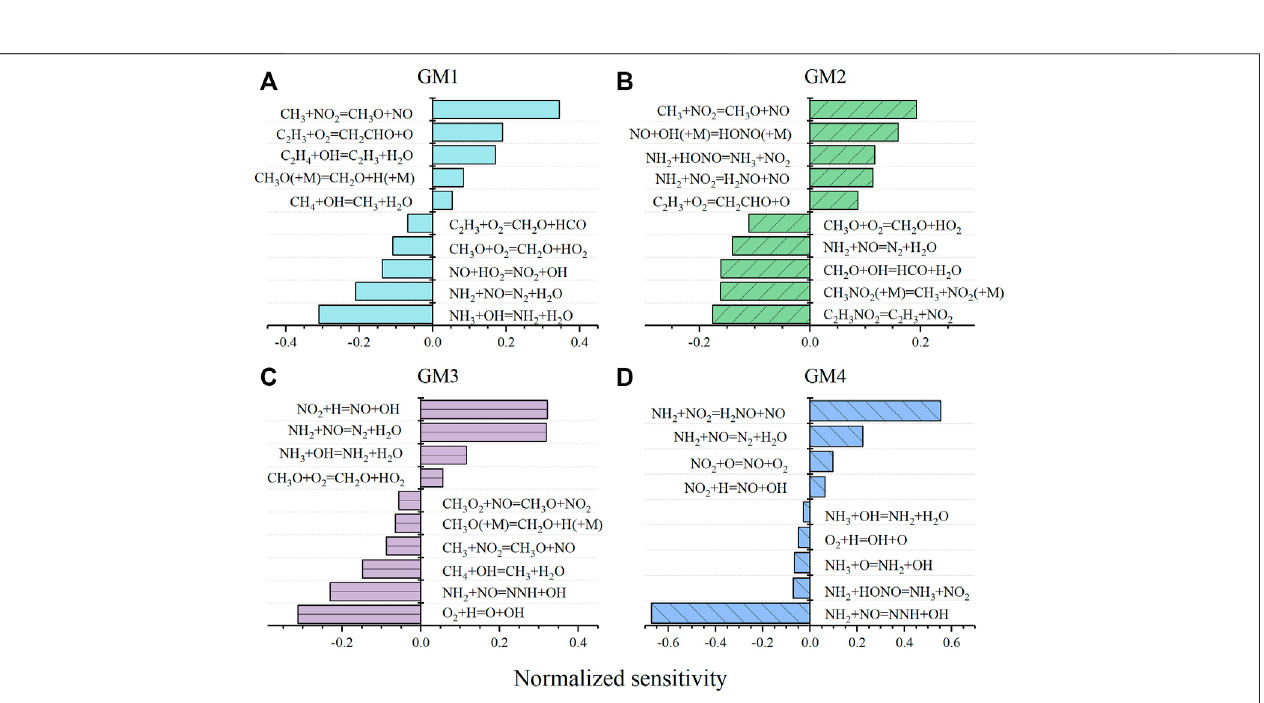
FIGURE 5 | Sensitivity analysis of NO during the fl ow reactor oxidation of GM1, GM2, GM3 and GM4 at 1213, 860, 911, and 1188 K, respectively. Negative sensitivity coef fi cients indicate promotion to NO consumption.